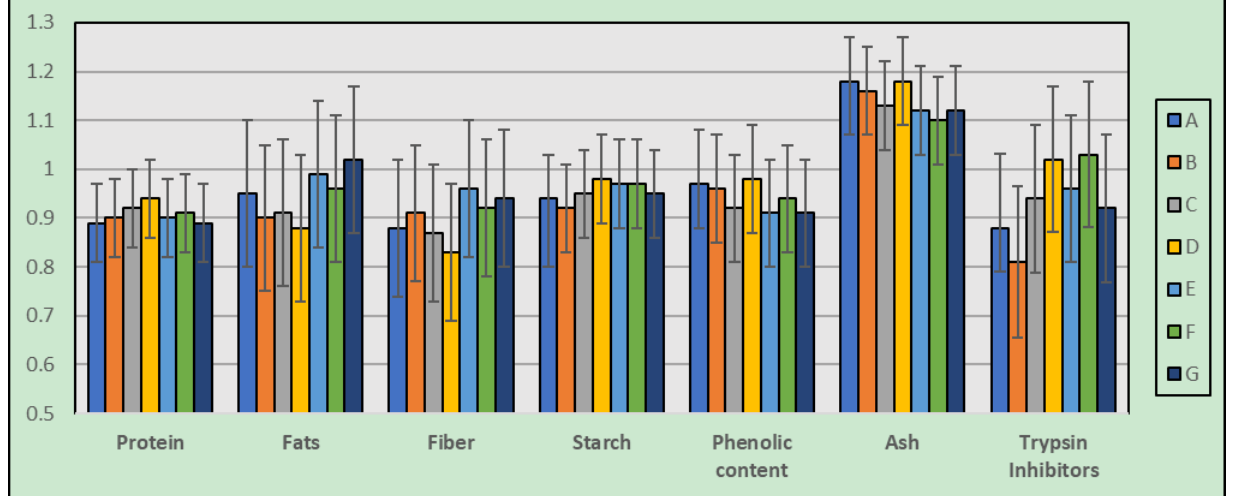
Figure 6. Nutritional evaluation of each genotype analyzed based on the mathematical model (error bars represent standard deviations, n = 3).